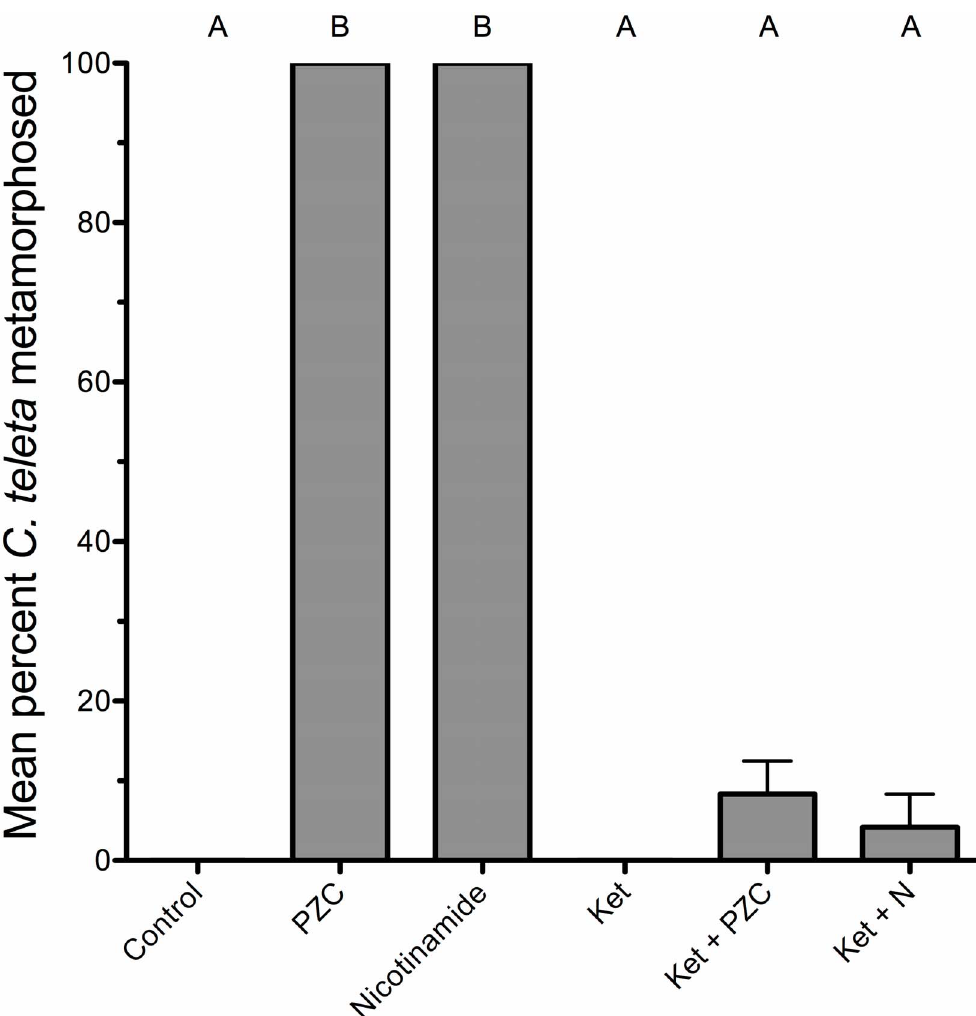
Figure 7. The effect of ketanserin on metamorphosis of C.teleta in the presence of nicotinamide or pyrazinecarboxamide. Larvae were acclimated to 2 m M ketanserin for three hours before being transferred to a solution of 2 m M ketanserin and either nicotinamide or pyrazinecarboxamide at 40 m M for 24 h. Each treatment consisted of 3 replicates with 8 larvae per replicate. Artificial seawater (Instant Ocean) acted as a negative control. Letters indicate significant (P , 0.05) differences as determined by a Bonferroni post-hoc test. Error bars represent + s.e.m. doi:10.1371/journal.pone.0109535.g007 activation of other serotonergic neurons. Nitric oxide may play a nergic signaling. Larvae of C. teleta did not metamorphose in the role as a secondary messenger between the influx of ions caused by presence NOS inhibitors when treated with ketanserin, a serotonin the opening of nicotinamide activated ion channels and seroto- 5-HT 2B receptor antagonist [20]. Serotonin binding to receptors Table 1. The lowest stimulatory concentrations of pyridines that induced larvae of C. teleta to metamorphose compared with the K M of these same chemicals on the pyridine-activated ion channel of the crayfish A. torrentium.